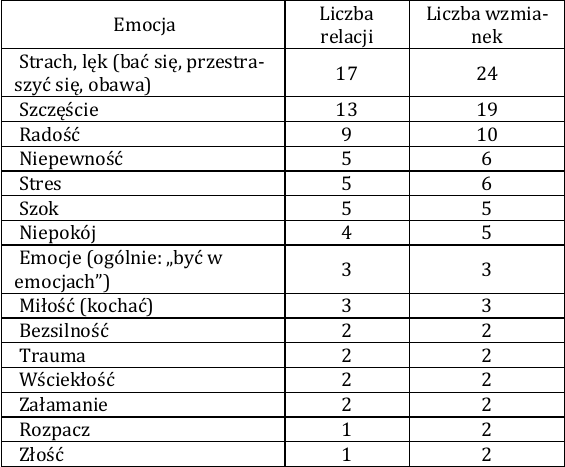
Tabela 1. Emocje przeżywane przez rodziców dzieci ho- spitalizowanych w